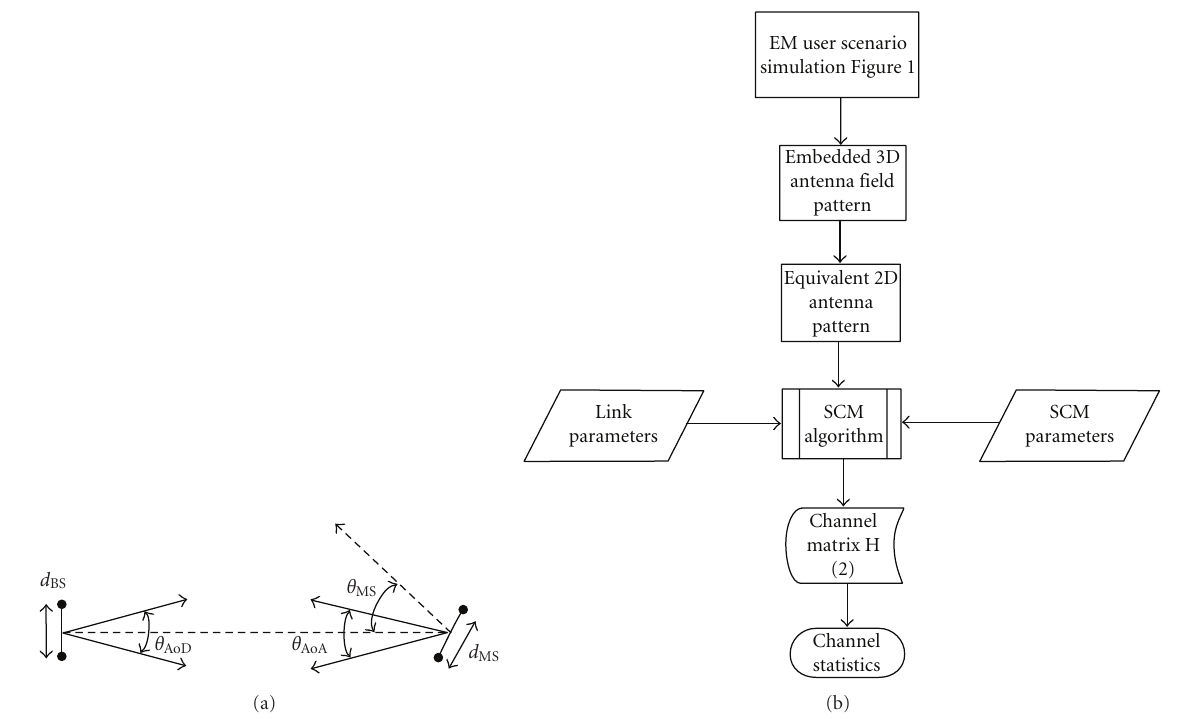
Figure 2: Simulation settings: (a) BS and MS array orientation, and (b) flowchart showing the SCM-EM integration.